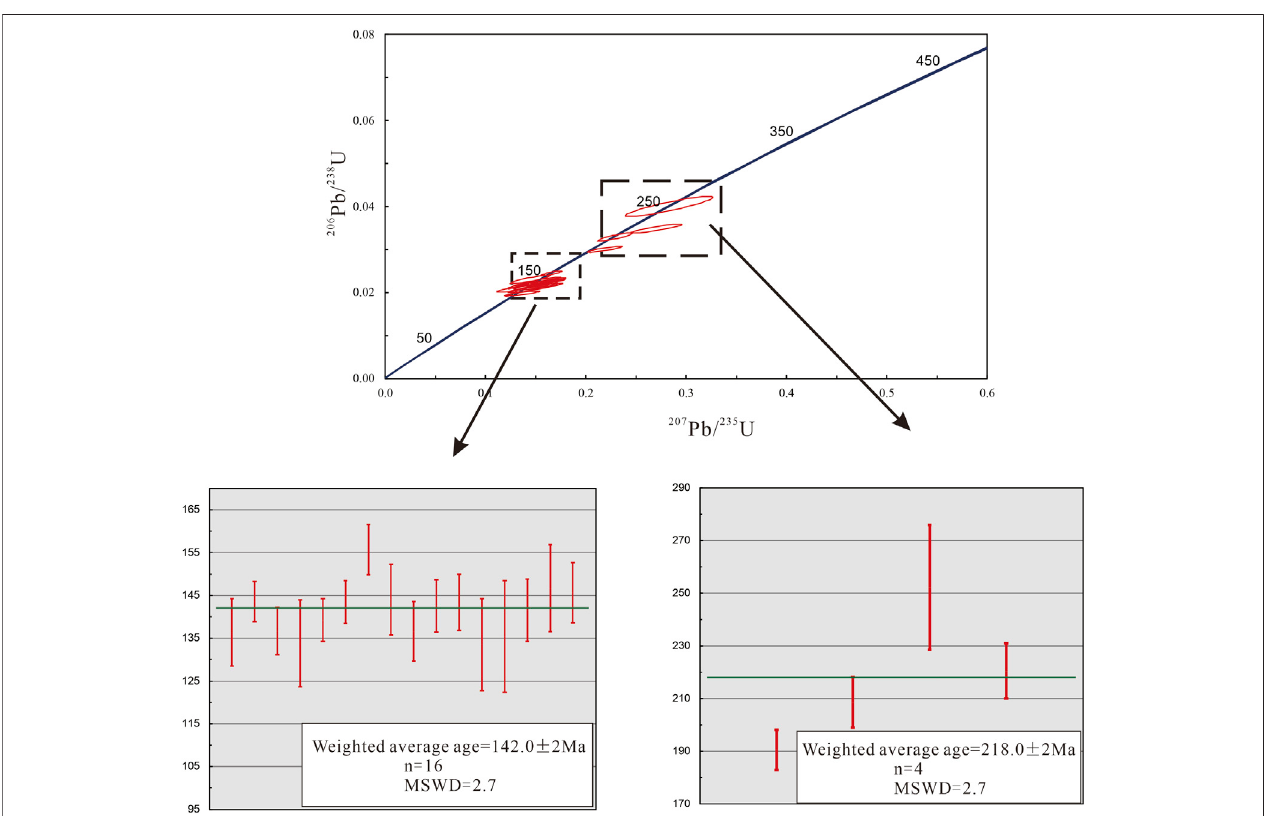
FIGURE 10 | Zircon U-Pb concordia diagram and weighted average age for the Zhaoxian deposit.